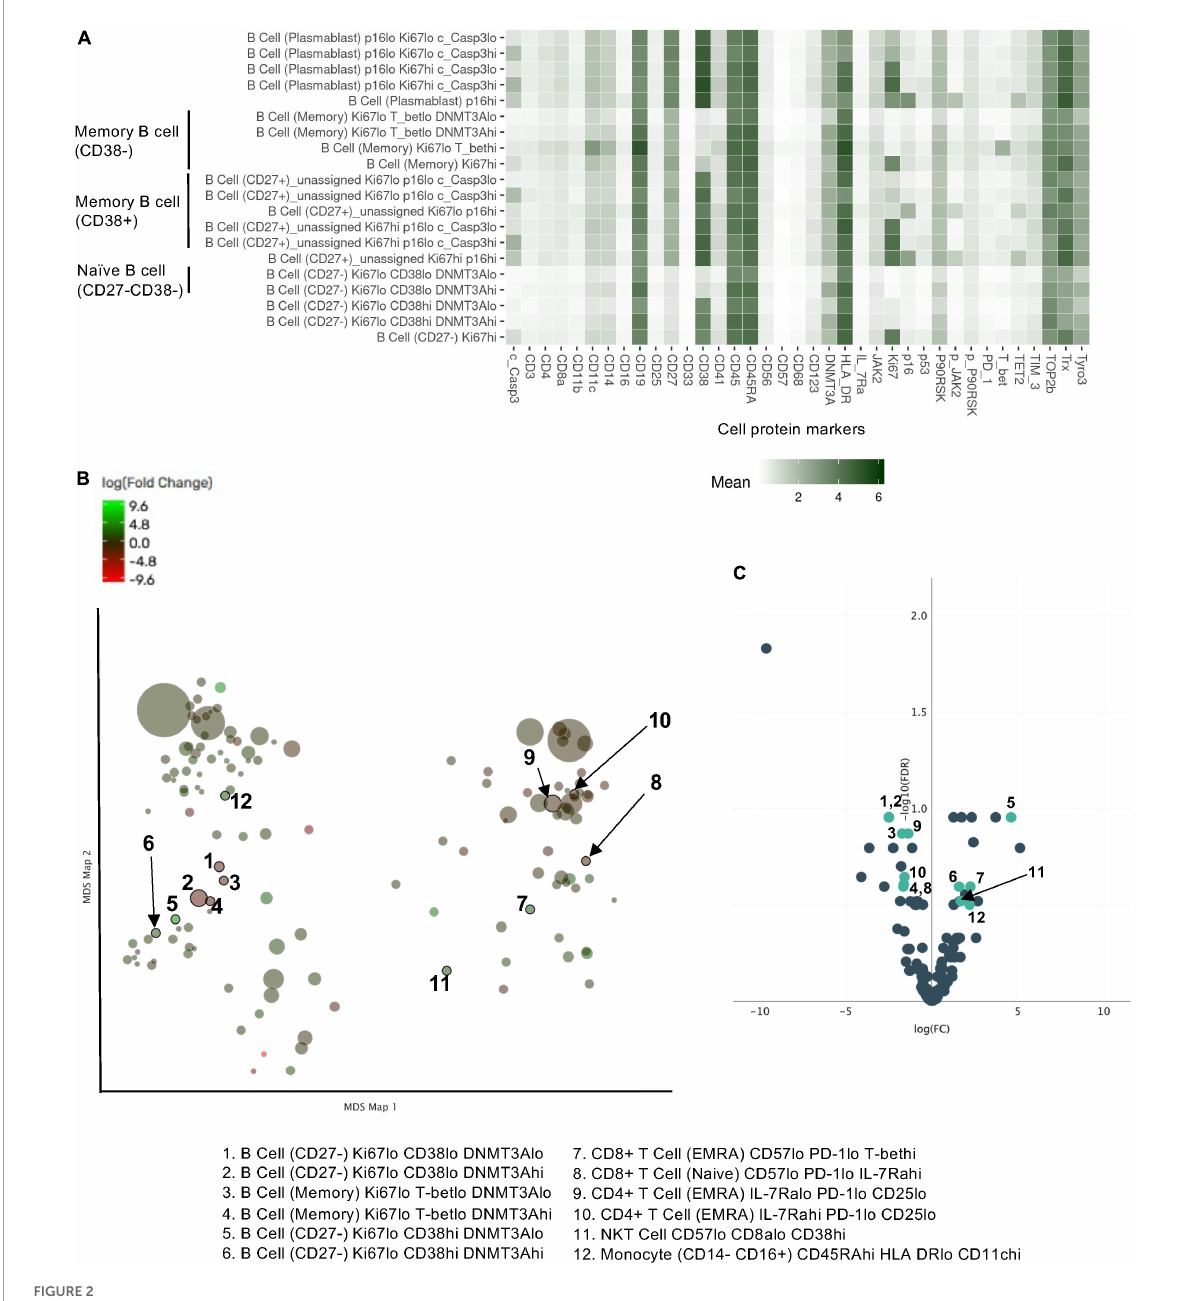
FIGURE2 Profiling subsets using the Astrolabe platform. (A) Profiling subset heat map for B cells only. Refer to Supplementary Figure 1 for the complete heat map. Rows are cell subsets; columns are channels. Tile intensity is the median value measured in each channel in each profiling. (B) Profiling of every cell cluster (138 clusters) was visualized using MDS. Each cluster is colored based on the logarithm of the ratio of intensity in the post-RT sample to pre-RT (baseline) sample. (C) A volcano plot of identified cell clusters profiled in (B) , showing those with –log10 [the false discovery rate (FDR)] > 0.5, log(FC) < –1 or 1 < log(FC) and p < 0.05 (student’s t -test) after RT (pre-RT vs. post-RT as described in Figure 4A and Supplementary Figure 2 ) in light green. Once the frequency data within –log(FDR) > 0.5 and log[fold change (FC)] < –1